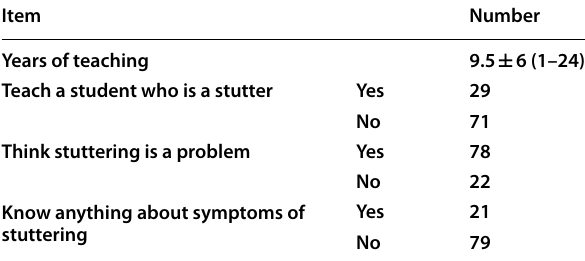
Table 3 Belief of teachers about behavior of students